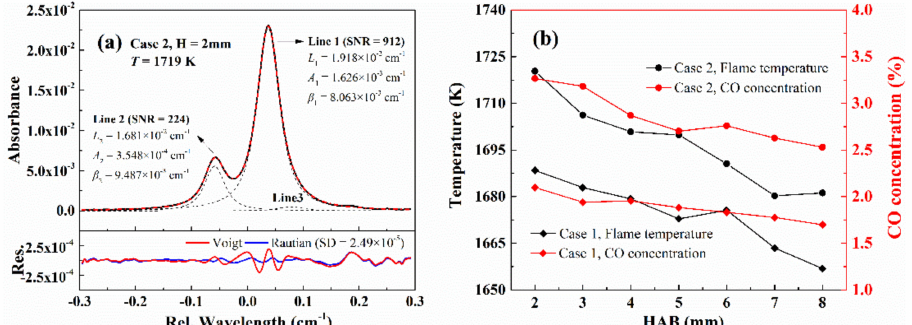
Figure 13. ( a ) An example of the recovered absorbance of CO in the CH 4 / Air flame together with the best-fit parameters. ( b ) The inferred flame temperature and CO concentraion for two